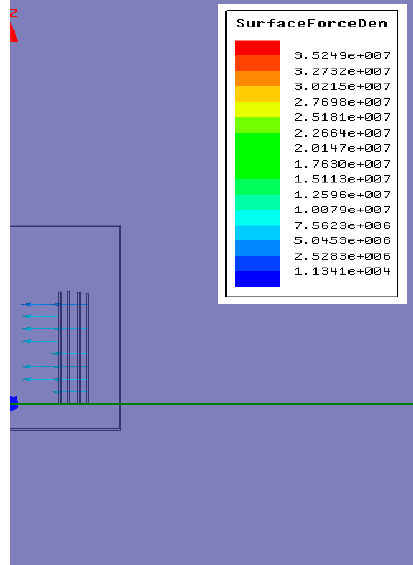
Figure 17. The surface force density distribution of the coupling reactor.